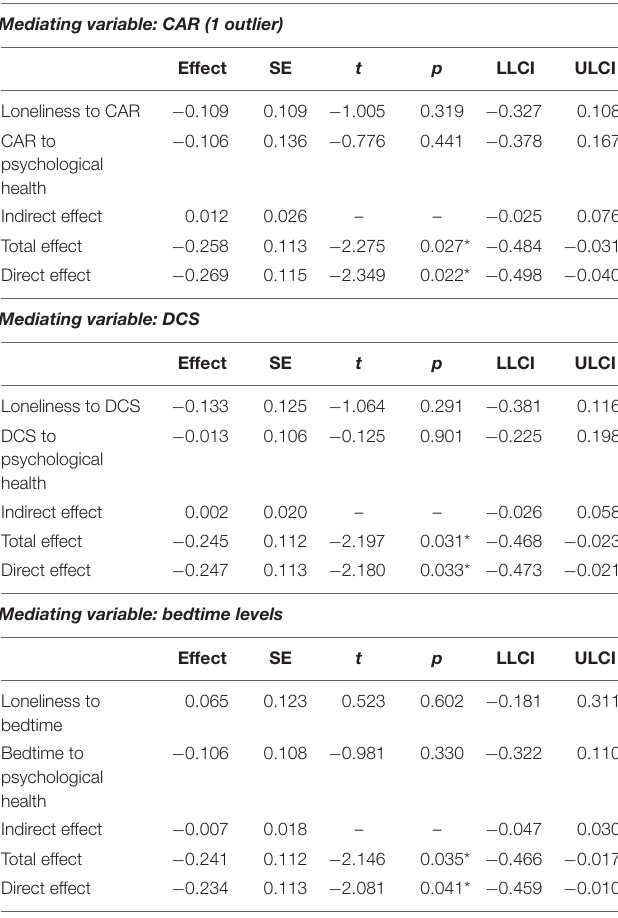
TABLE 4 | Adjusted moderation analyses with loneliness as a predictor and psychological and physical health and cortisol indexes as dependent variables in males and females.